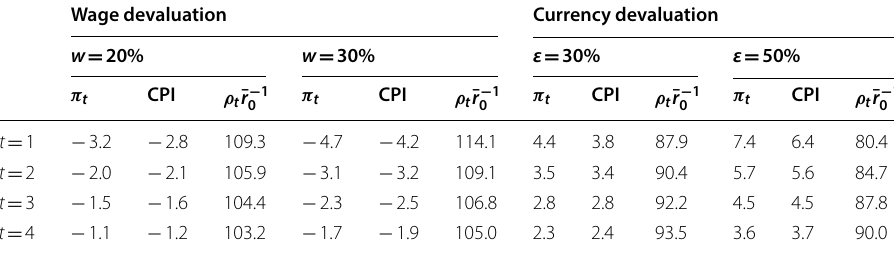
Table 7 The evolution of the average inflation rate, CPI and average real profit rate (%); Italy Wage devaluation